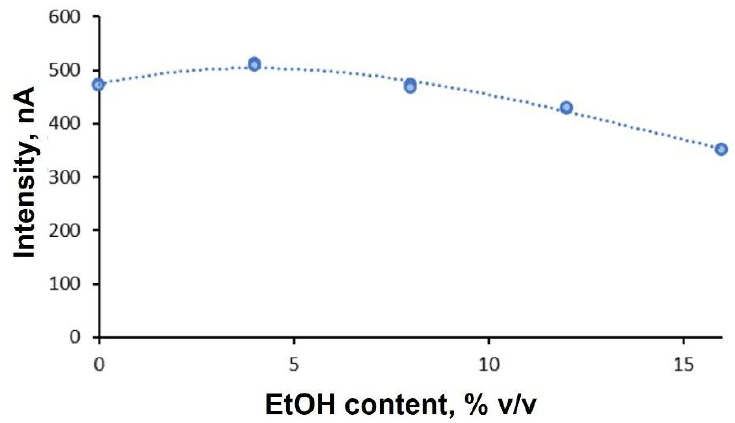
Figure 9. Influence of ethanol on the sample through dispersive microextraction.